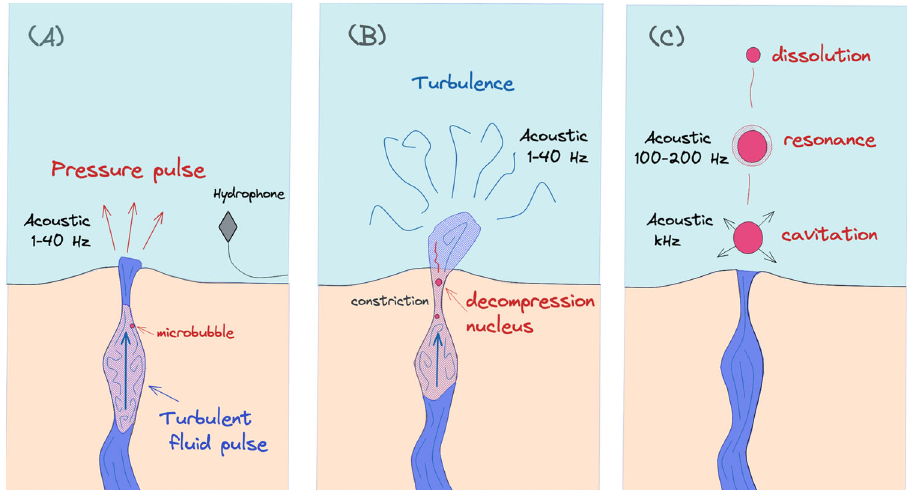
Fig. 4 Conceptual model. A A fl ow instability generated by the interaction of the hydrothermal fl uid with the sediment matrix (e.g., a fl owpath constriction), momentarily depressurizes the fl uid, triggering the nucleation of a CO 2 bubble in the saturated fl uid with pre-existing microbubbles ( B ). The bubble oscillates at its natural frequency before dissolving into the under-saturated lake water or rising to the lake surface ( C